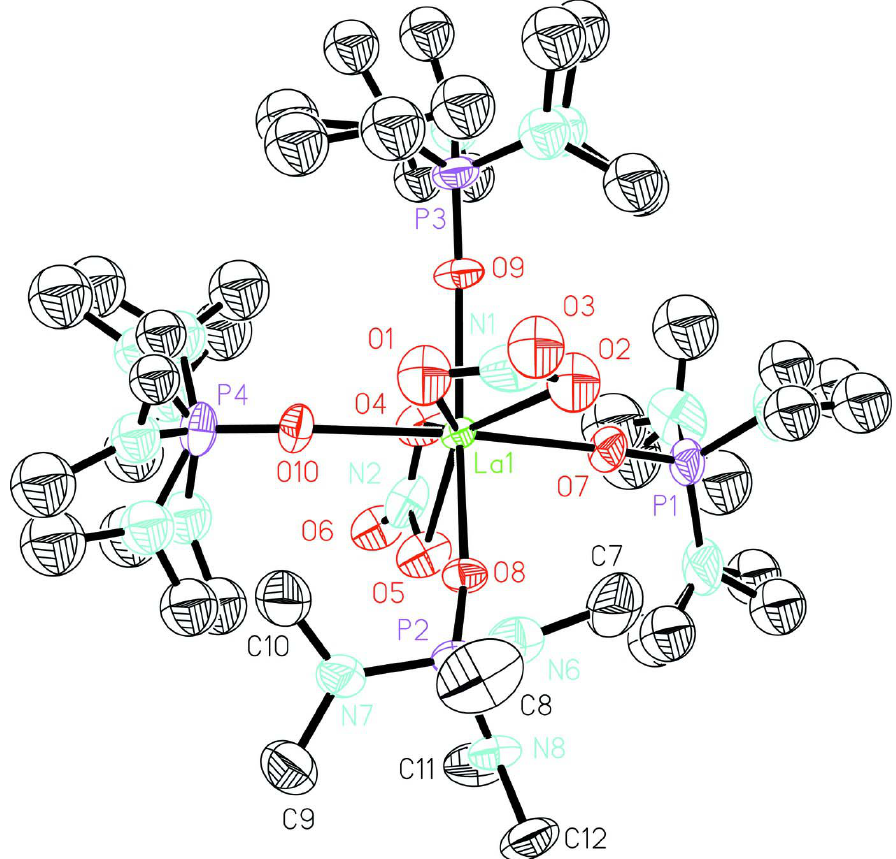
Figure 1 The molecular structure of the cation in the title compound, with atom labels and 30% probability displacement ellipsoids. All H atoms have been omitted.